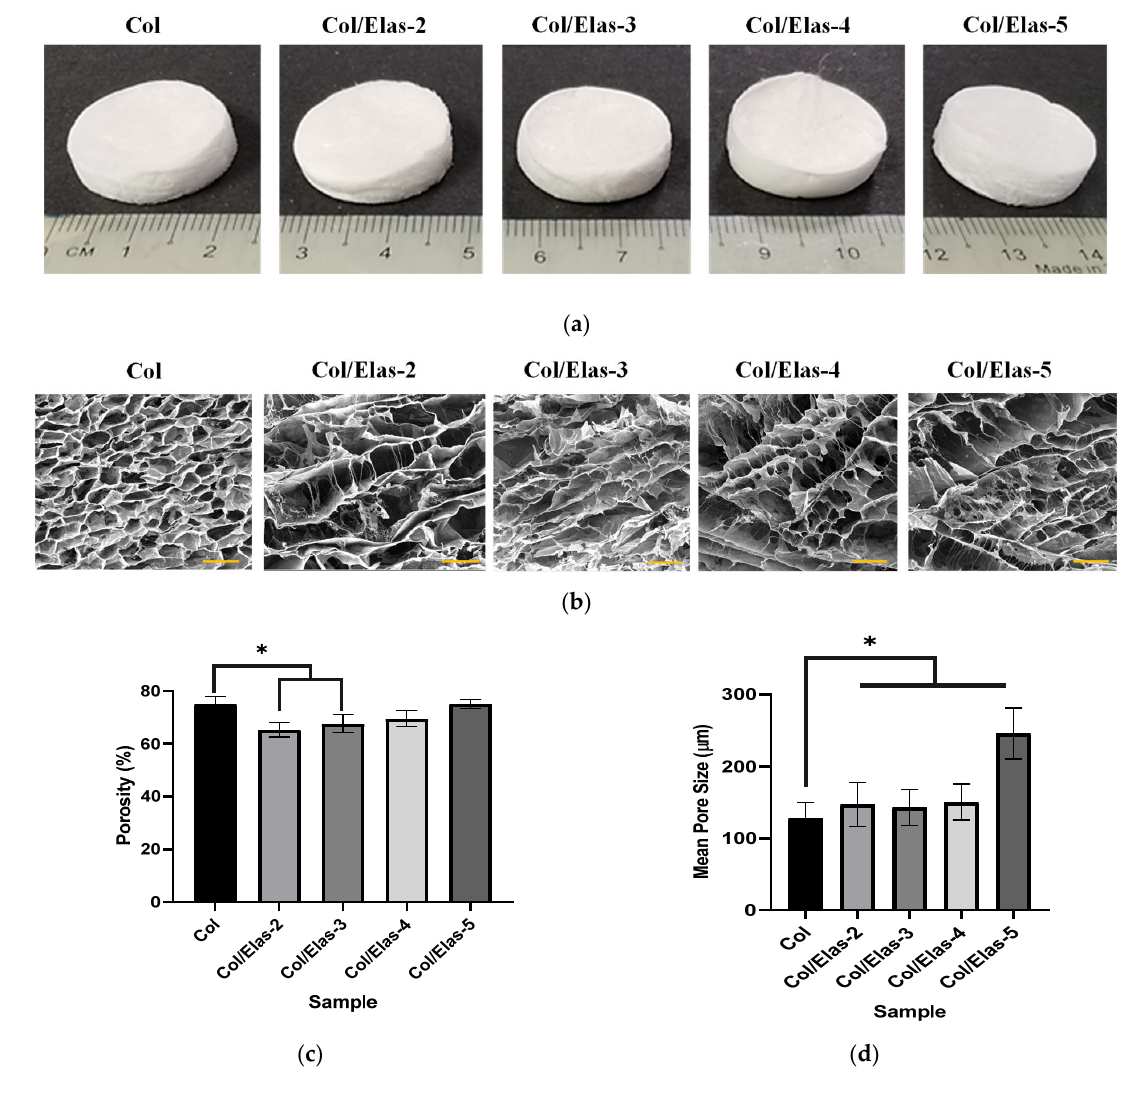
Figure 1. ( a ) Gross appearance of the genipin-crosslinked scaffolds after crosslinking at 25 ◦ C. ( b ) The cross-sectional FESEM images of the scaffolds at 100 × magnification (Scale bar = 200 µ m). ( c ) Measured porosity of Col/Elas scaffolds. ( d ) Mean pore sizes of Col/Elas scaffolds. (*) represents a significant difference ( p < 0.05; n = 3) between the